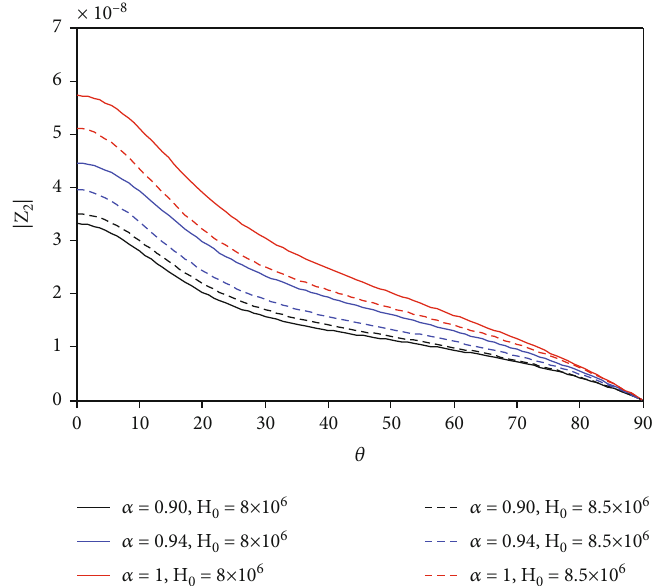
j concerning the angle of incidence θ for various values of the fractional parameter of the 2